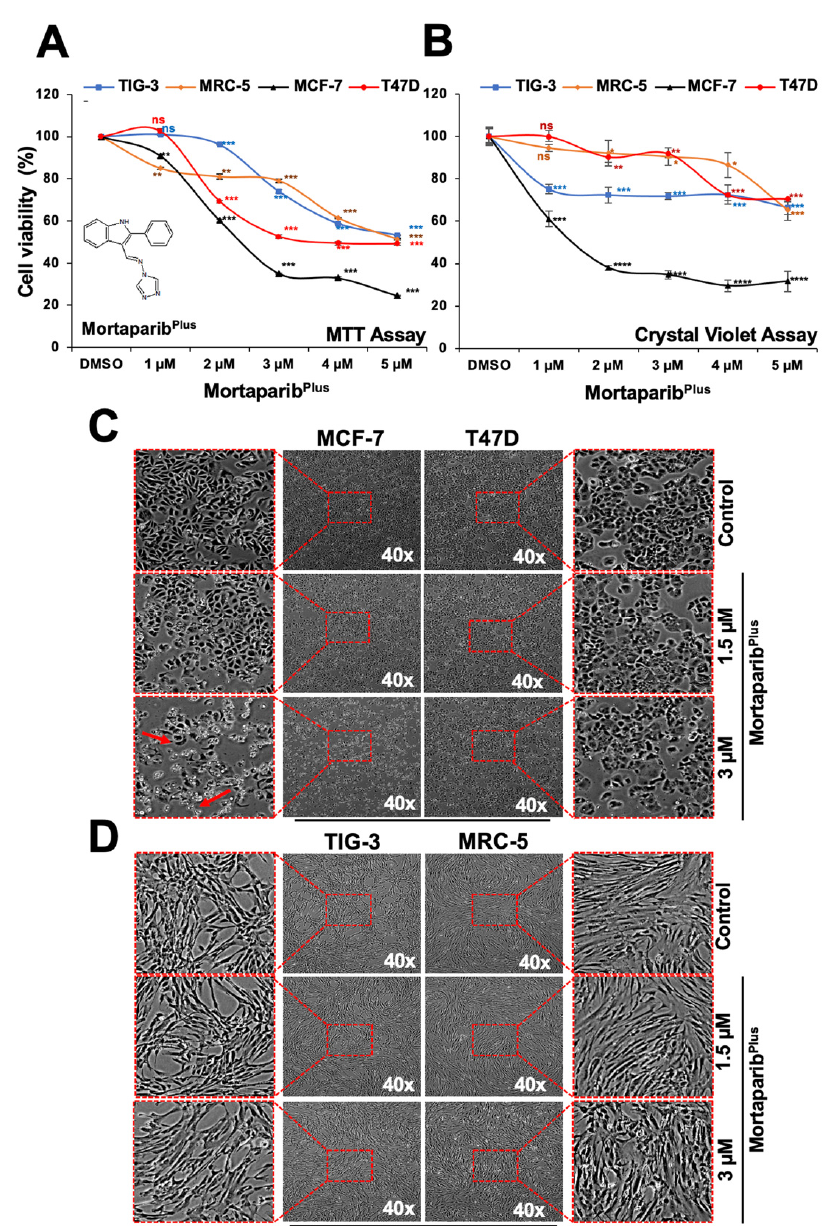
well as T47D cells (Figure 2A,B); however, only MCF-7 (wild type p53) showed stimulation of the transcriptional activation function of p53.